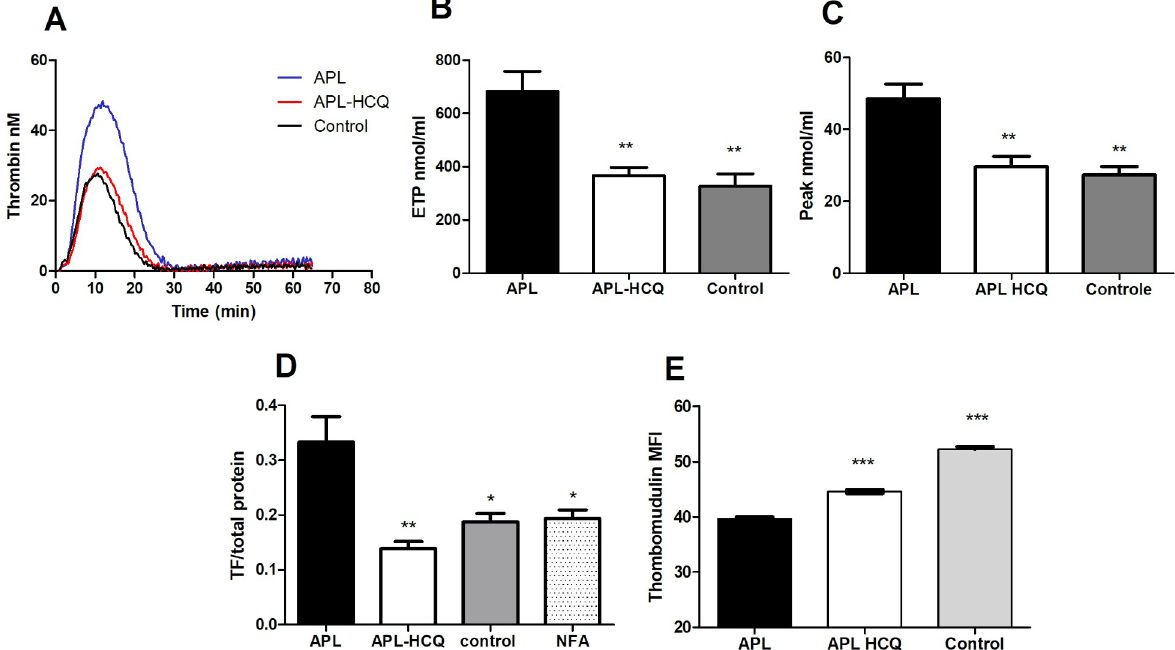
Fig 3. Effects of HCQ on procoagulant and inflammatory properties in endothelial cells. (A)Thrombin generation curves, (B) endogenous thrombin potential, and (C) peak thrombin measured in the presence of Activated C protein (APC) by calibrated automated thrombography (CAT) in HAEC. (D) Tissue factor expression measured in HAEC with or without niflumic acid 0.1mM by western blotting (E)Thrombomodulin quantified by flow cytometry assay, expressed in mean fluorescence intensity. (MFI) Values are mean ± SEM � : P < 0 . 05 ; �� : P < 0 . 01 ��� : P < 0 . 001; n = 5 /